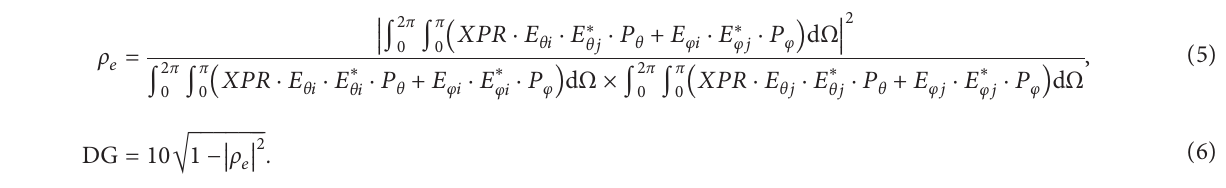
Figure 20. Measured MEG 1 and MEG 2 are close to − 3 dB in